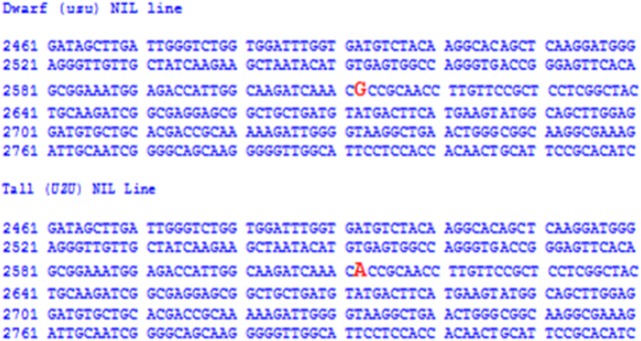
Sequences of the HvBRI1 homologs cloned from tall and dwarf NIL lines segregating only for the ‘TX9425’ semi-dwarfing locus.The comparison of the sequences identified the single base pair mutation from A to G at site 2612.